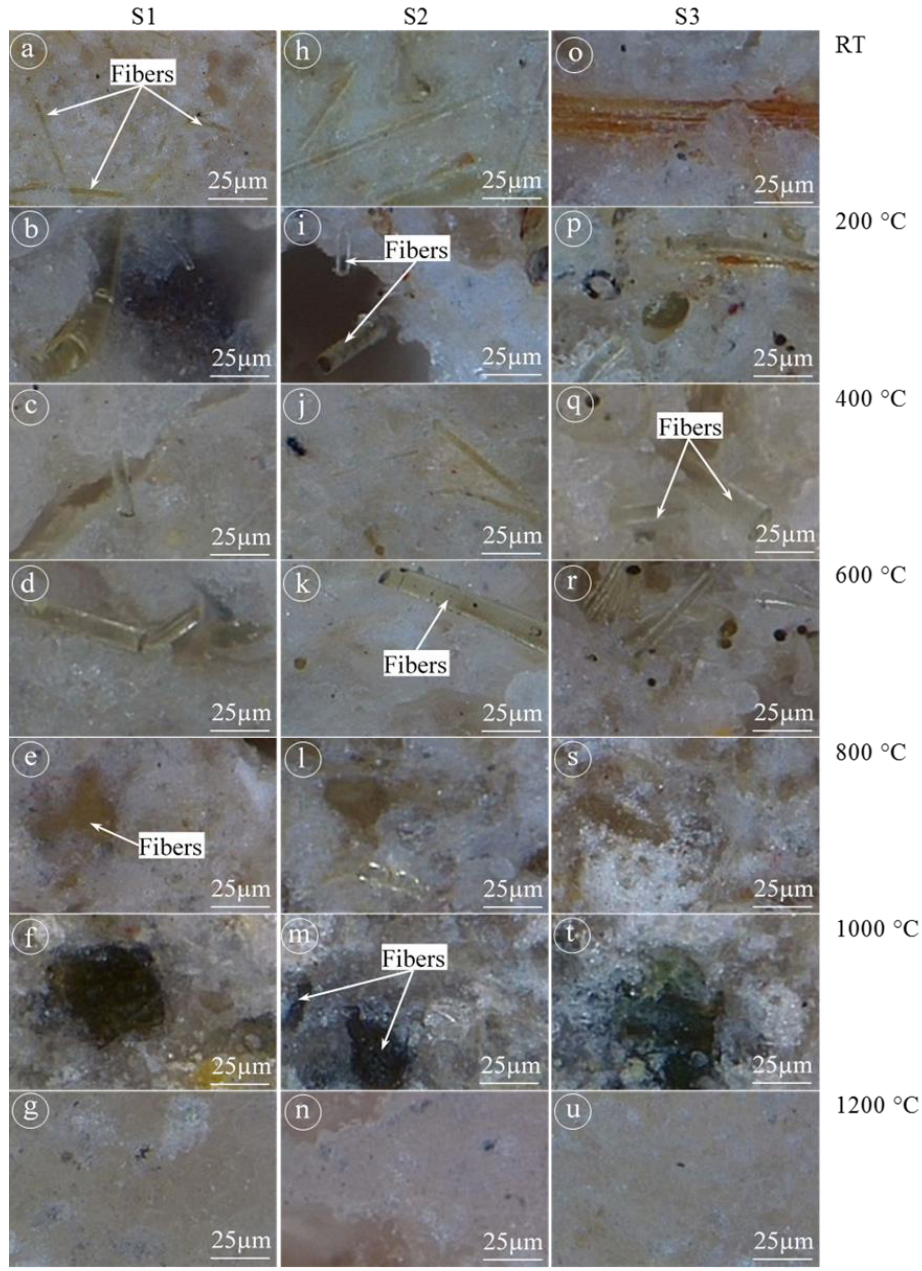
Figure 7. Optical micrographs of BGF samples at elevated temperatures: ( a – g ) for S1, ( h – n ) for S2, and ( o – u ) for S3.